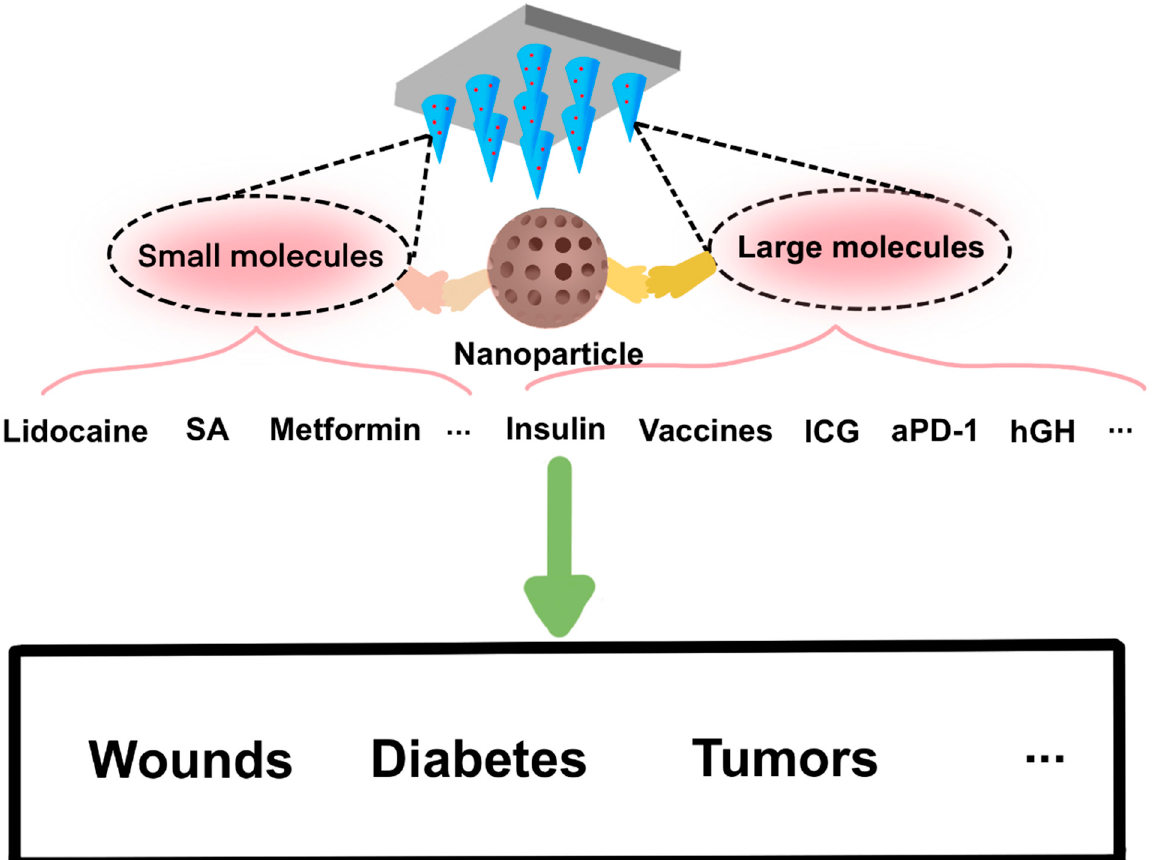
Figure 7. Schematic representation of MNs with small and large molecules in the application of wounds repair, diabetes and tumor therapy.